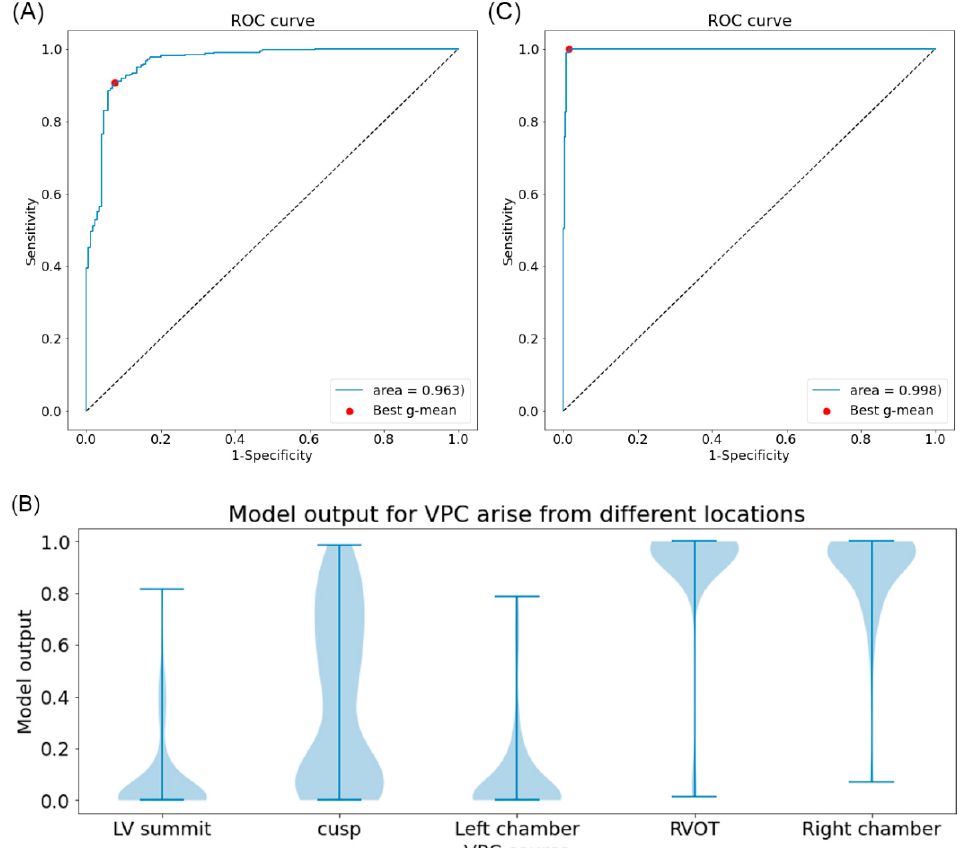
Figure 4. Receiver operating characteristic (ROC) of models for classifying ventricular premature contraction and distribution of model output from a different location. ( A ) The ROC of the model for distinguishing VPC from the left or right ventricle. The red dot indicates the best geometrical mean (g-mean) of sensitivity and specificity. ( B ) The vertical line of each group indicates the range of the values. The width of the plot indicates the ratio of data with this value. (LV summit: VPC from left ventricle summit, Cusp: VPC from right coronary cusp, left coronary cusp, right and left cusp junction. Left chamber: VPC from the aorto-mitral curtain, Left anterior fascicle, mitral annulus, left ventricular papillary muscle, RVOT: VPC from right ventricle outflow tract. Right chamber: VPC from right ventricular parahisian, pulmonary artery, right ventricular moderator band, tricuspid annulus). ( C ) The ROC of the model for identifying VPC from the summit of the left ventricle. The red dot indicates the best geometrical mean (g-mean) of sensitivity and specificity.